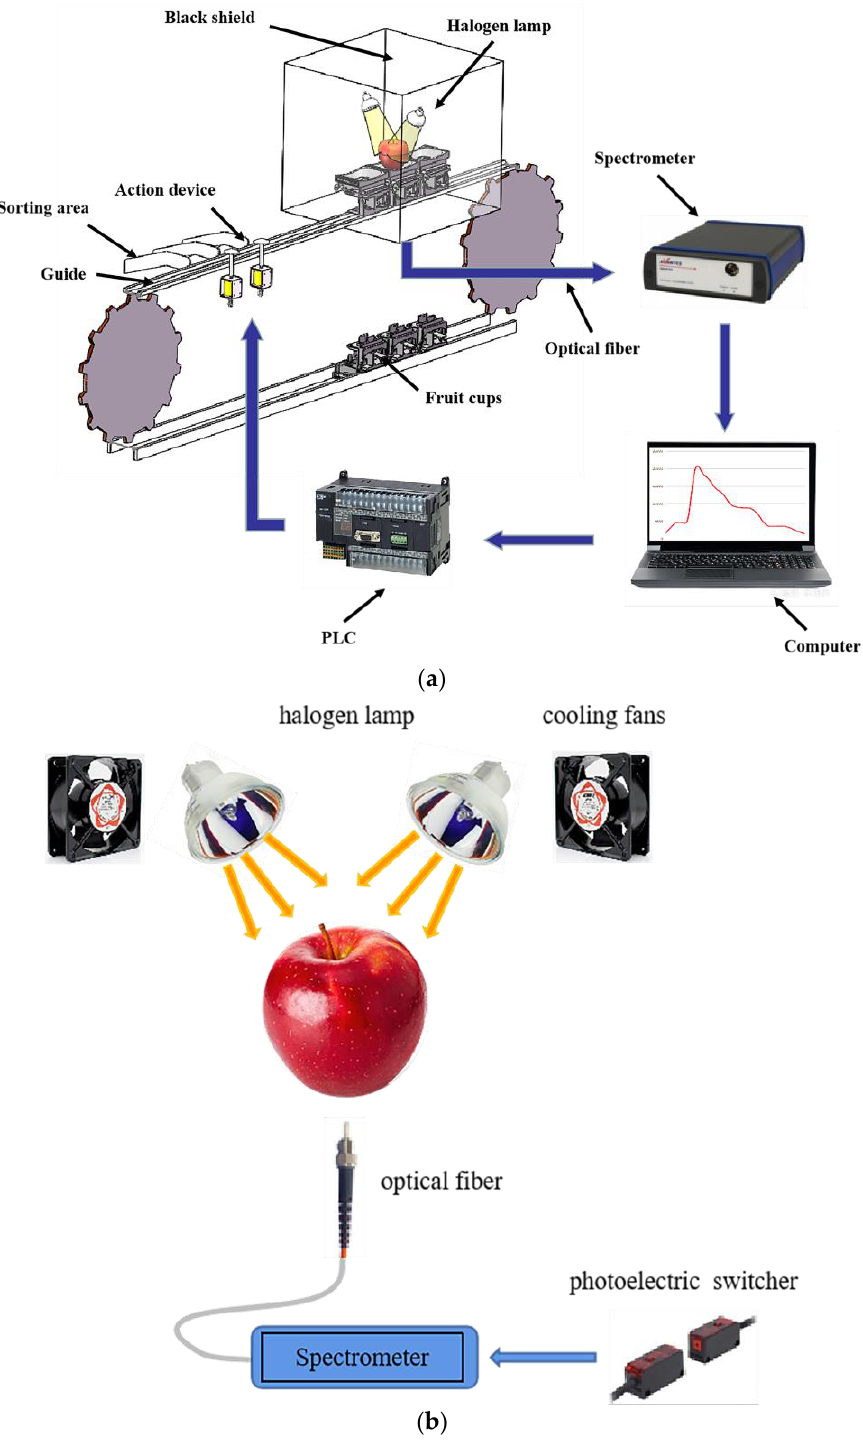
Figure 1. The apple online detection equipment. ( a ) Components of the whole machine system; ( b ) spectral detection unit.